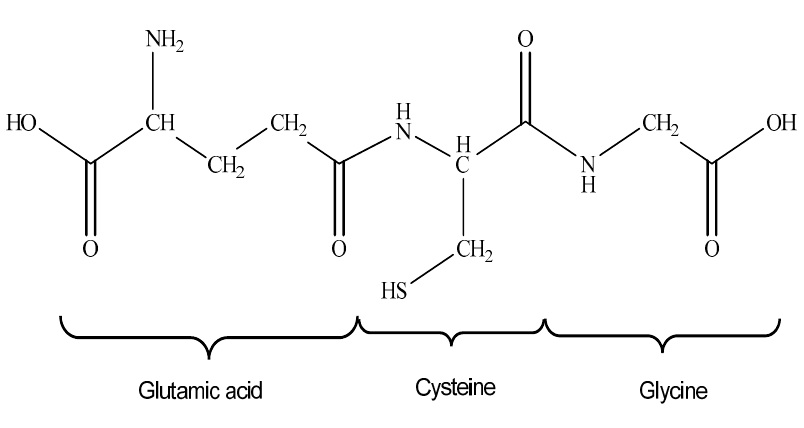
Figure 3. The structure of